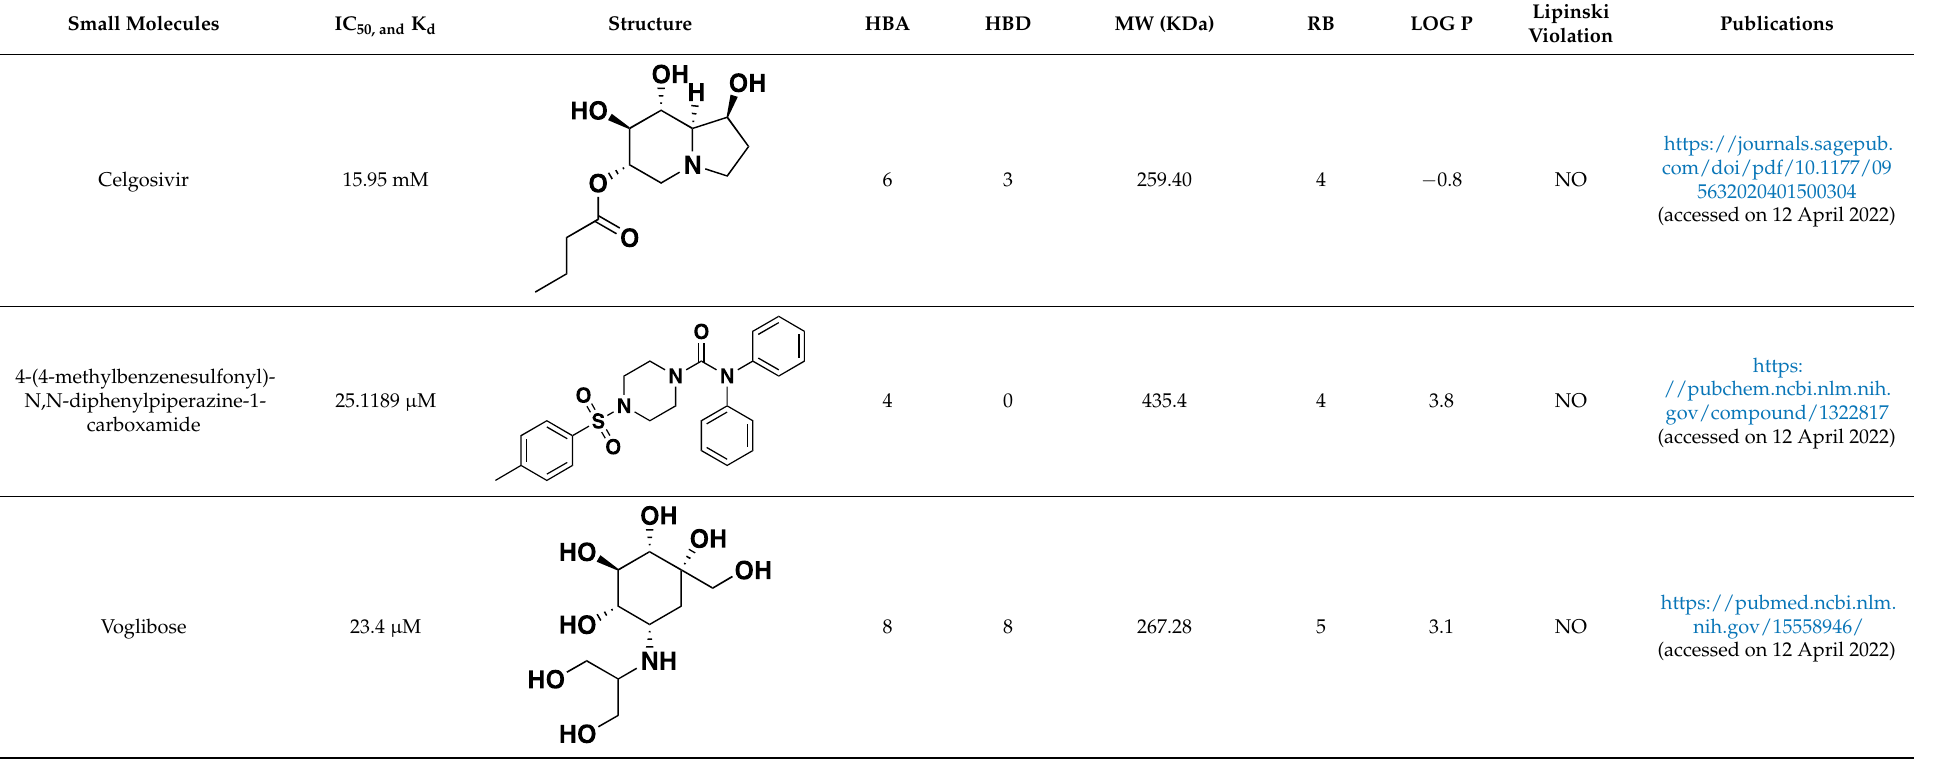
Table 1. Most active compounds are used to form pharmacophore queries for screening purposes.